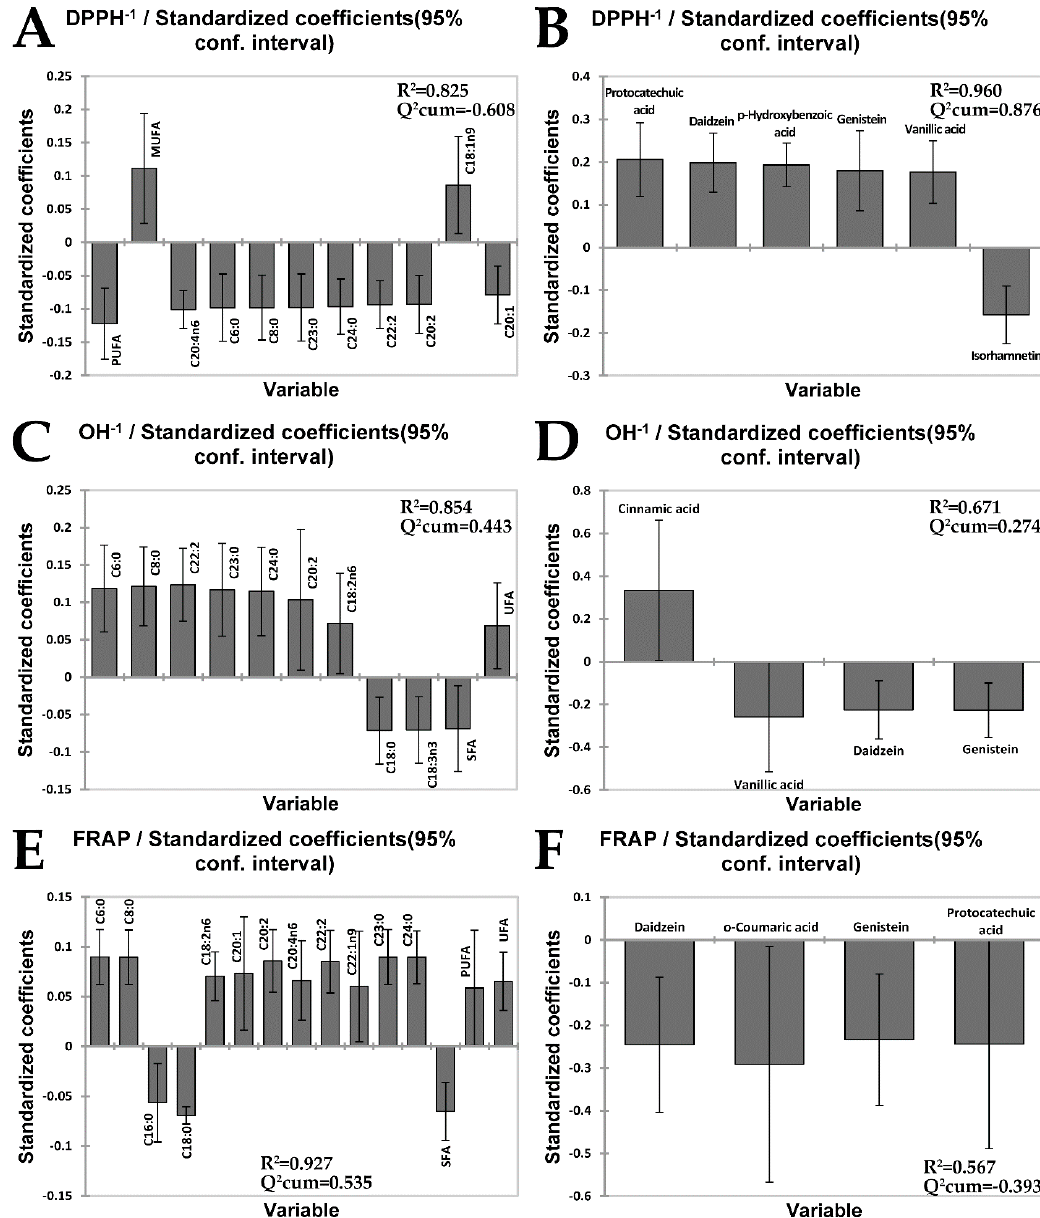
Figure 2. A separate one-component PLSR model for each dependent variable. The variation in the AO activity of the extracts in regard to fatty acid and phenolic profiles estimated by DPPH ( A , B ), OH ( C , D ) and FRAP ( E , F ) assays.